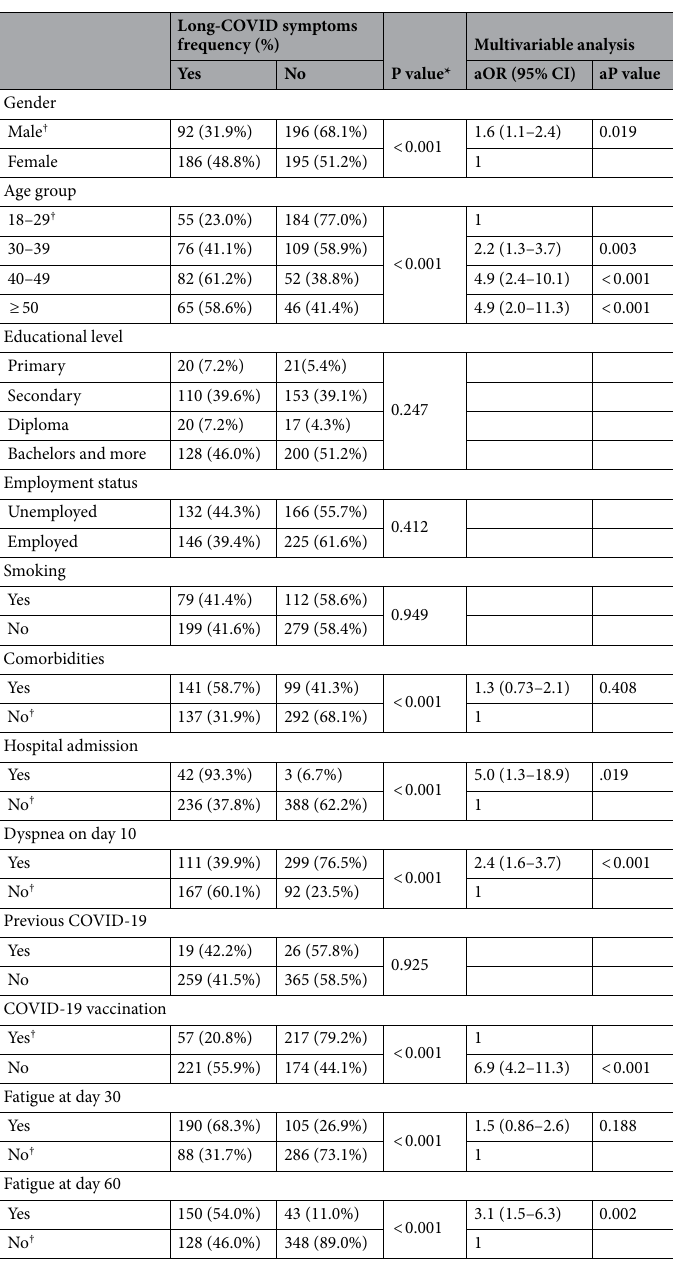
Table 4. Bivariable and multivariable analysis of factors related to long-COVID symptoms (n = 669). aP-value adjusted P value, aOR adjusted odds ratio, CI confidence interval. † Reference group, *Chi-square